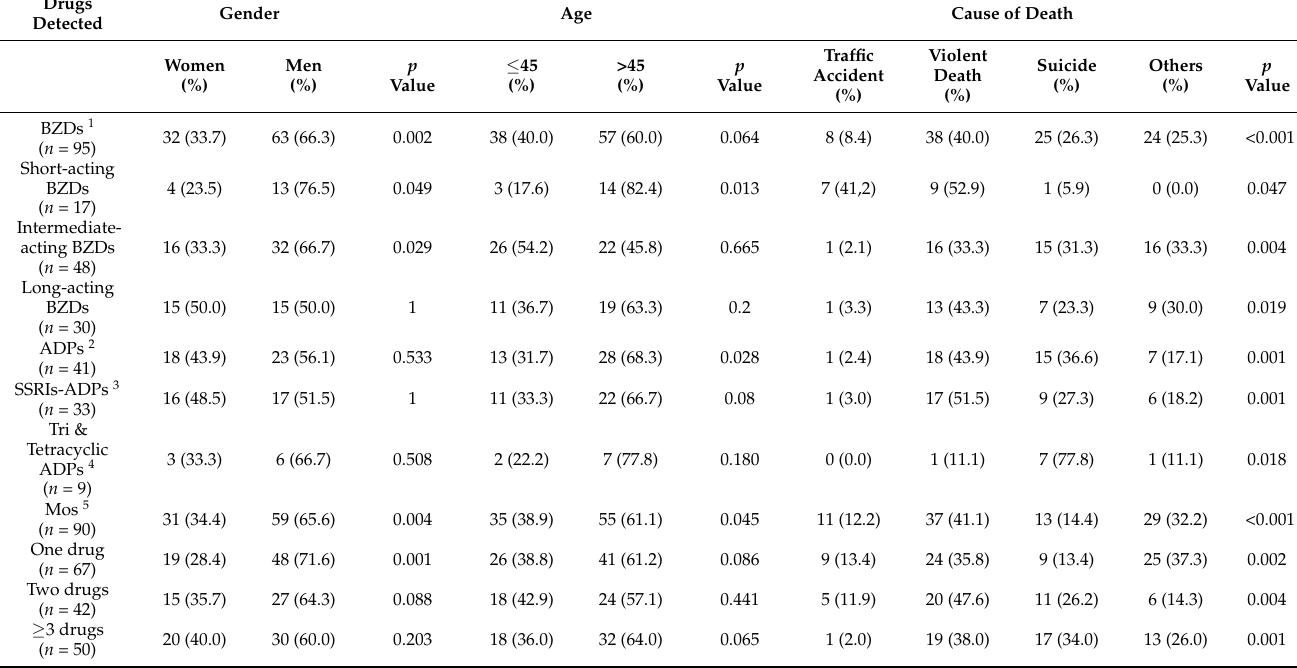
Table 3. Relationship between sociodemographic and forensic variables and detected